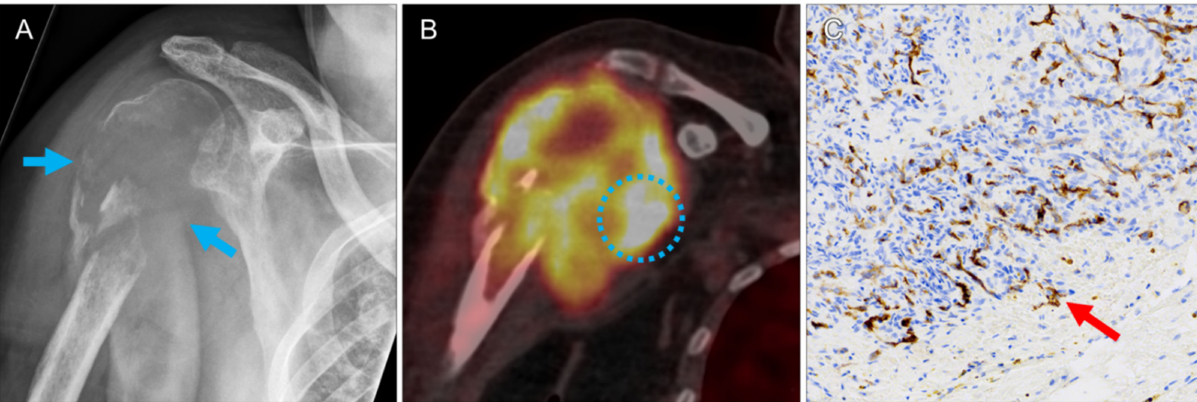
Figure 1. Large osteolytic ccRCC bone metastasis (lesion 8). X-ray shows destruction of the proximal right humerus (( A ), arrows). PET/CT reveals extensive soft tissue infiltration of the lesion ( B )), with the highest tracer uptake observed in this study (circle; SUVmax 23.4). Intense PSMA expression on the microvasculature of the mass (( C ), brown structures, arrow). No intact bone structures were seen in this biopsy specimen.